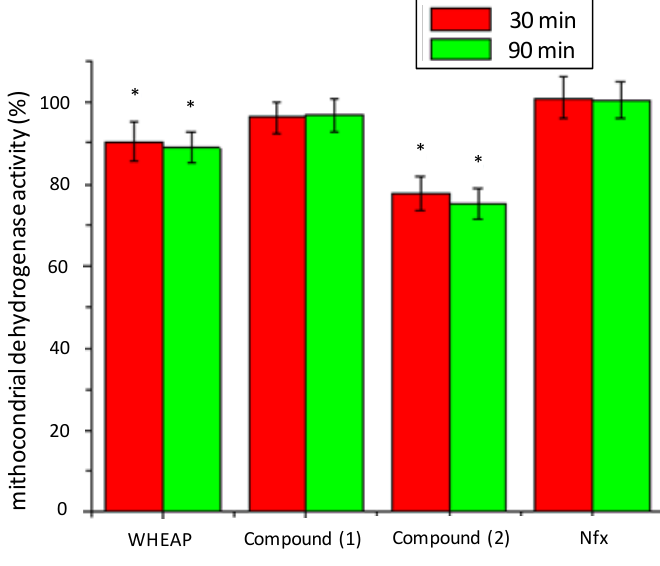
Figure 6. Mitochondrial dehydrogenases activities (%) compared to untreated control of T. cruzi epimastigote, Y strain, with time and compound. Bnz did not produce depletion of mitochondrial dehydrogenase activity at 20 μ M in these conditions [21]. The experiment was done in duplicate. * Statistically different to untreated control (Student’s t test) ( p <